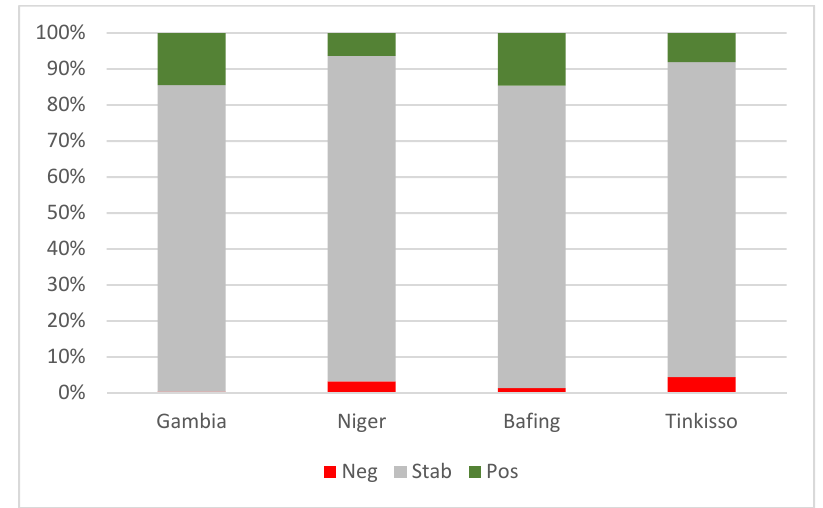
Figure 10. Part of the vegetation trends on the four main basins in the Bafing River basin.